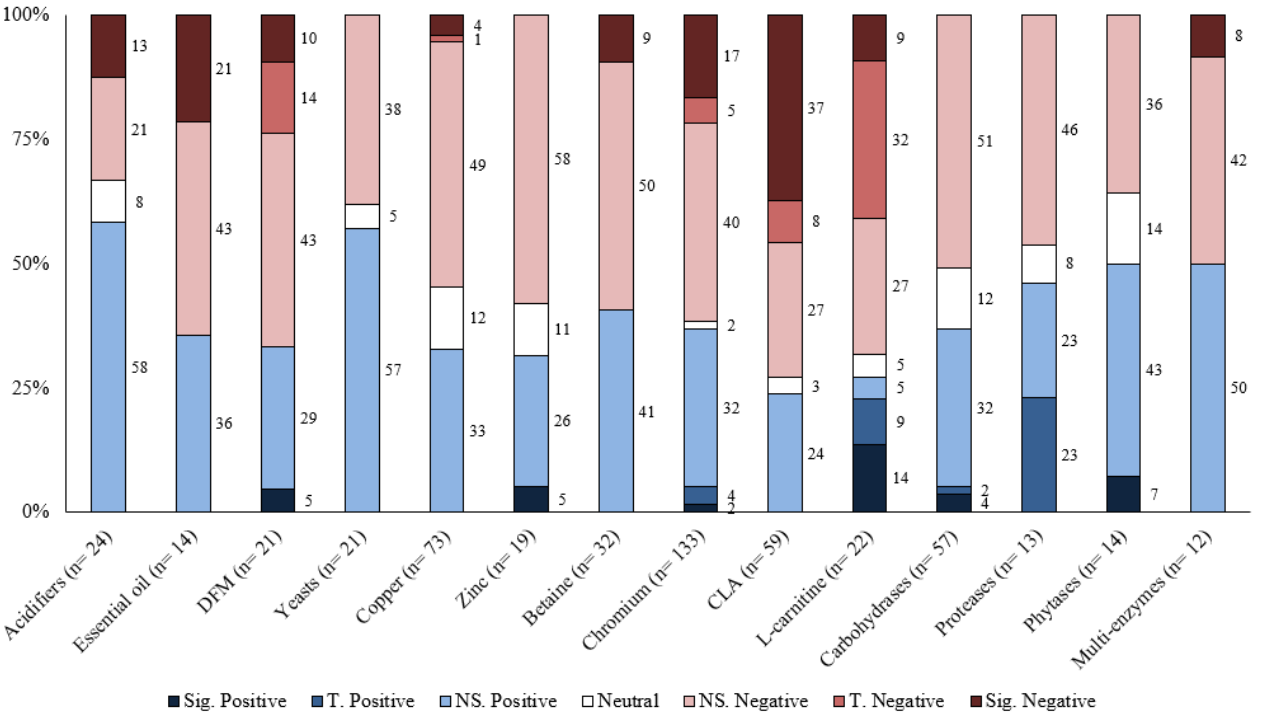
Table 4. Summary of the effects of feed additives on grow–finish pig percentage lean 1,3 .